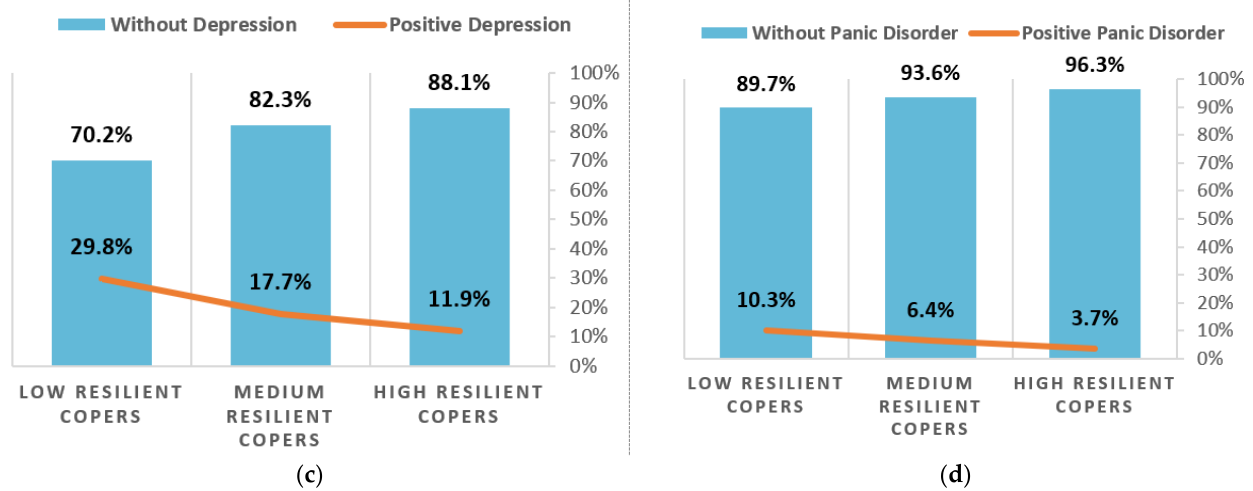
Figure 3. Effect on resilience on mental health: ( a ) Resilience and PTSD. ( b ) Resilience and anxiety. ( c ) Resilience and depression. ( d ) Resilience and panic disorder.